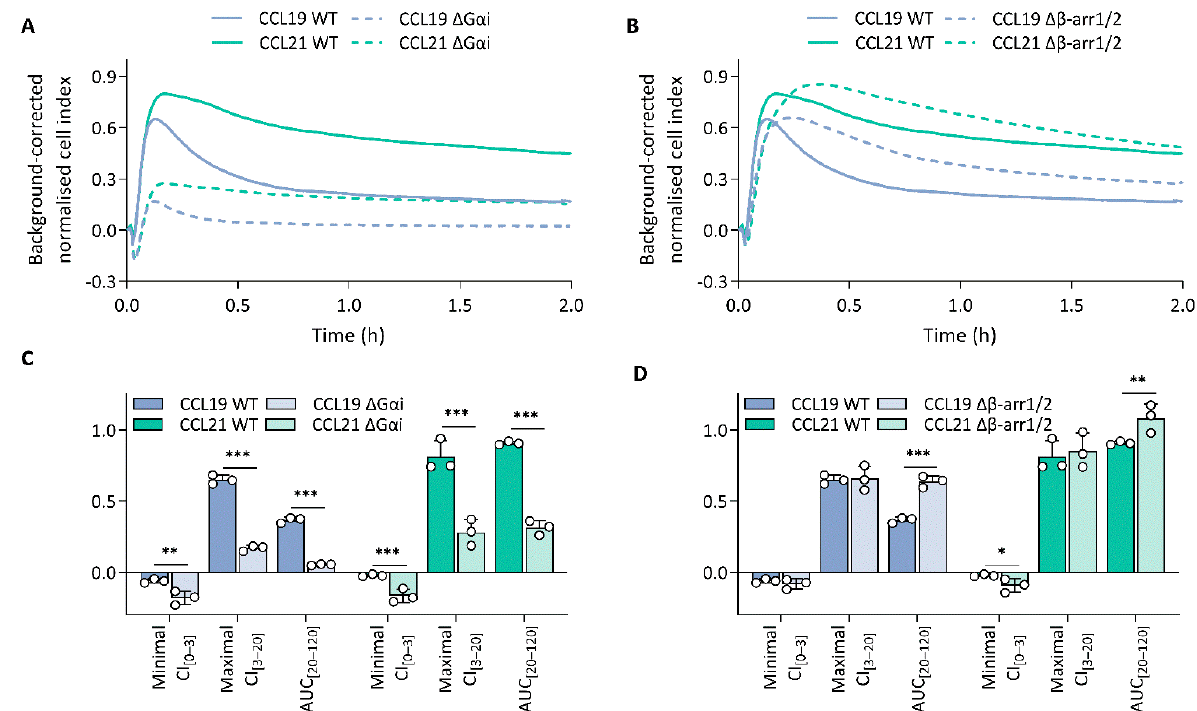
Figure 2. G α i-mediated signalling dominates the impedance profile and β -arrestins modulate it. ( A , B ) CCR7 impedance profiles induced by CCL19 (100 nM) or CCL21 (250 nM) in CCR7-expressing wild-type (WT) and ( A ) G α i knockout (KO) ( ∆ G α i) or ( B ) β -arrestin1/2-KO ( ∆ β -arr1/2) HEK293 cells. Data are represented as the mean (line) of three independent experiments with two technical replicates each. SDs are not shown for visual clarity. ( C , D ) The effect of ( C ) G α i-KO ( ∆ G α i) and ( D ) β -arrestin1/2-KO ( ∆ β -arr1/2) on the minimal CI [0–3] , maximal CI [3–20] and AUC [20–120] following treatment with either CCL19 (100 nM) or CCL21 (250 nM). Data are represented as the mean (bar) and SD of three independent experiments (points) with two technical replicates. A one-way ANOVA followed by a Dunnett multiple comparison was used to assess the effect of the KOs compared to the wild-type cells. *, **, and *** represent p < 0.05, 0.01 and 0.001, respectively.